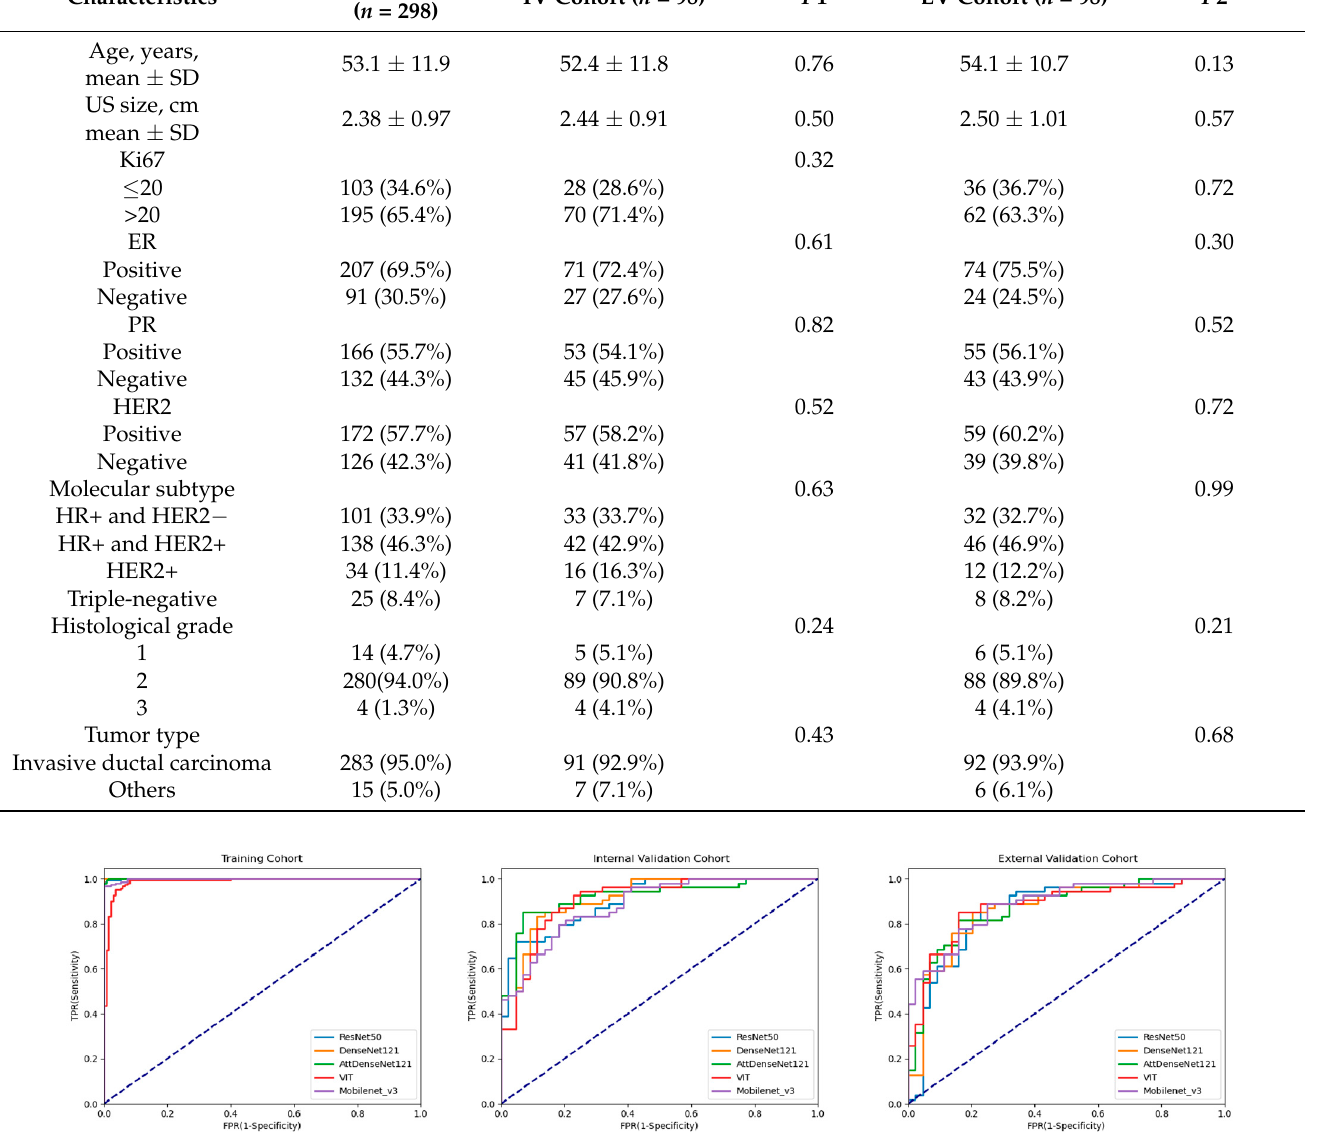
Figure 3. Comparison of ROC curves among DL models for predicting TIL levels in the training cohort, internal validation, and external validation cohort. AttDenseNet121 attention-based DenseNet121, VIT Vision Transformer.